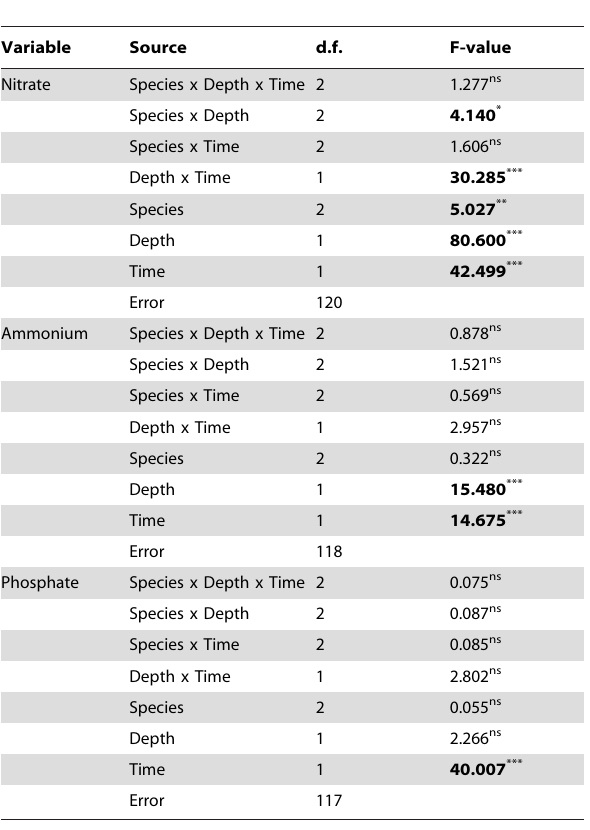
Table 1. ANCOVA results for available nutrients in soil